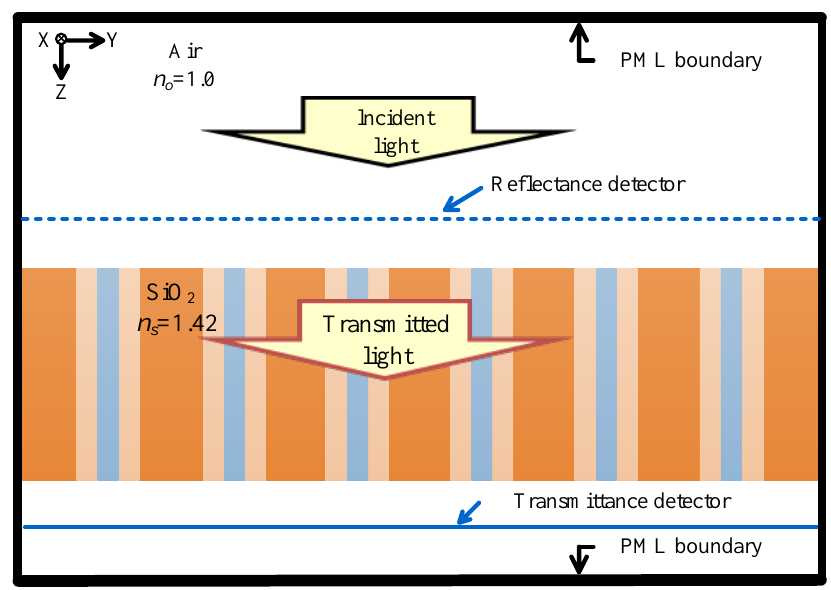
Figure 2. Sketch of a light-wave propagation through a CMOS compatible thermopile with SHA simulated by the finite-difference time-domain (FDTD) method.